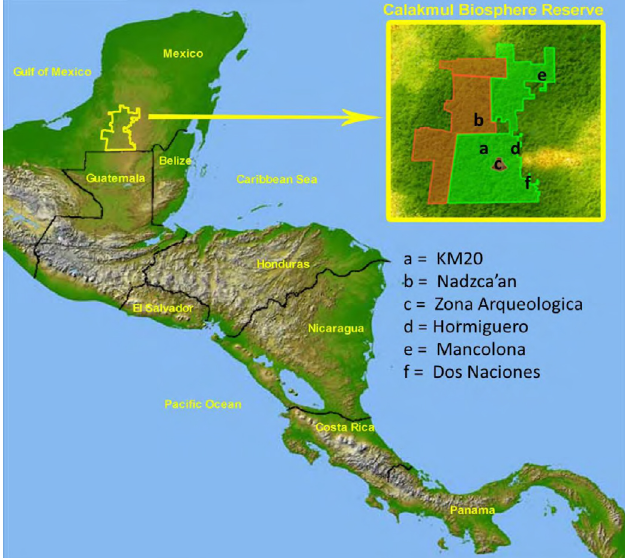
Figure 1. Location of Calakmul Biosphere Reserve within the southern Yucatán Peninsula. Study sites within the reserve are also indicated. KM27 and KM40 are not shown due to their close proximity to KM20 and Zona Arqueologica respectively. Green shading on inset represents the pro- tected reserve (core and buffer zones) and orange shading indicates the connected state reserves of Balam-kim and